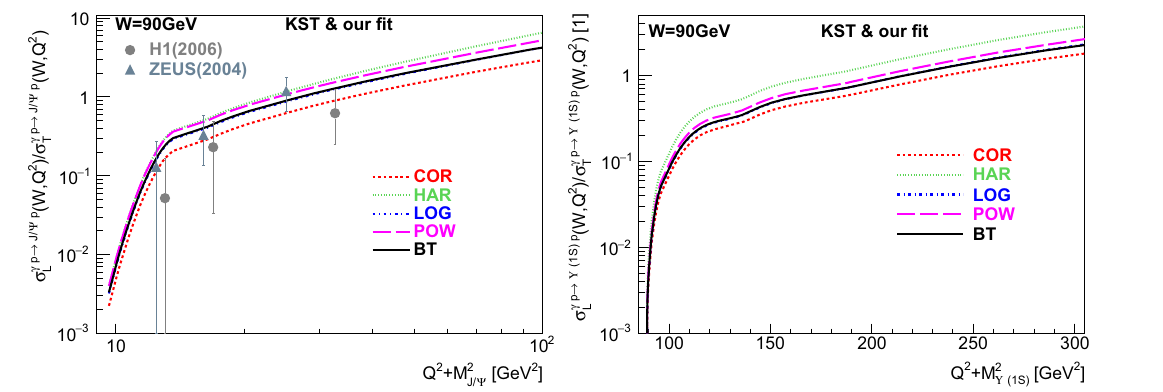
Fig. 25 The ratio of integrated cross sections for elastic electropro- duction of longitudinally ( L ) and transversely ( T ) polarized J /ψ( 1 S ) (left panel) and ϒ( 1 S ) (right panel) as a function of the scaling variable Q 2 + M 2 (left panel) and Q 2 + M 2 ϒ (right panel) at fixed c.m. energy J /ψ W = 90 GeV. The data are taken from H1 [76] and ZEUS [79] collab-